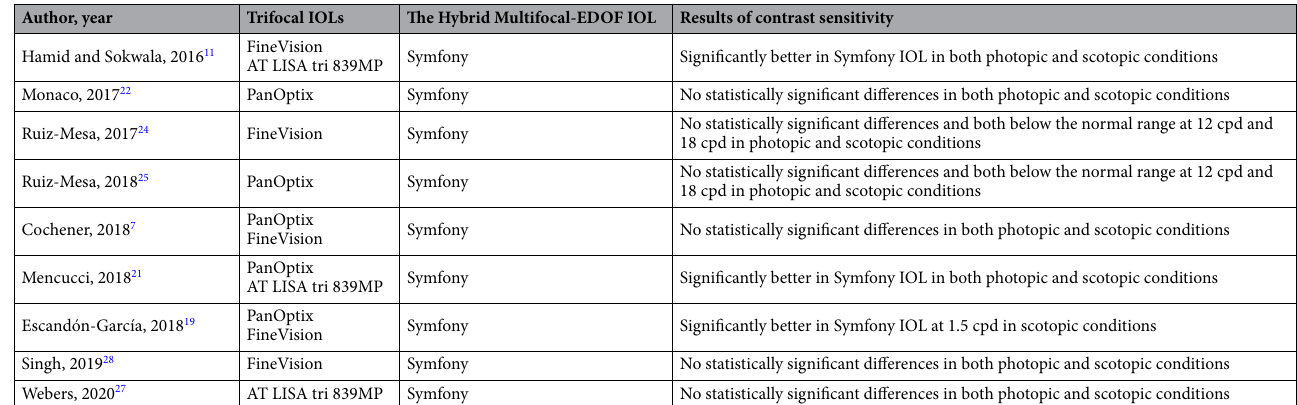
Table 3. Descriptive information of contrast sensitivity. EDOF, extended depth of focus; IOL, intraocular lens; cpd, cycles per